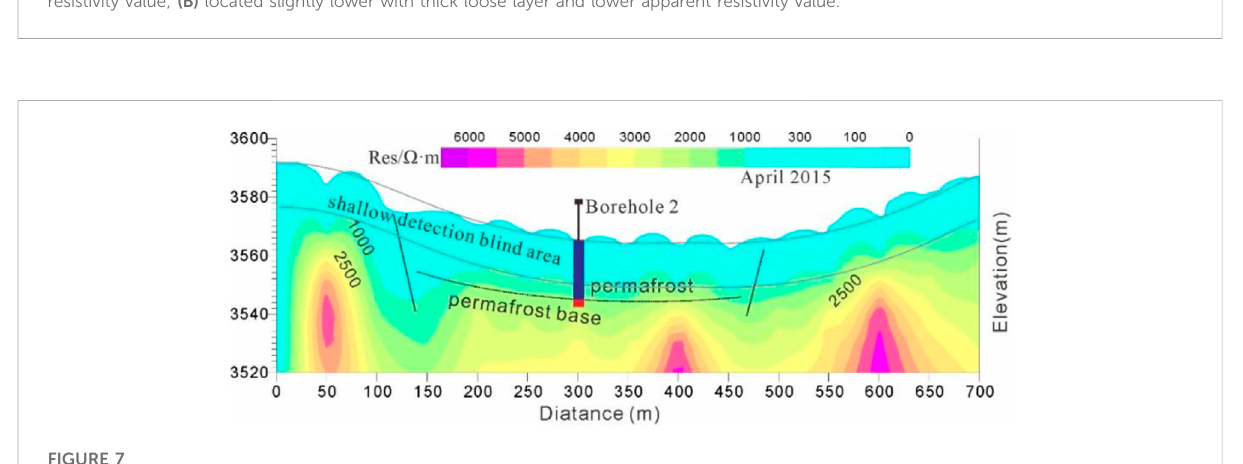
FIGURE 6 Two permafrost DC sounding curves of Mahan Mountain. (A) located on the top of the mountain with thin loose layer and higher apparent resistivity value; (B) located slightly lower with thick loose layer and lower apparent resistivity value.